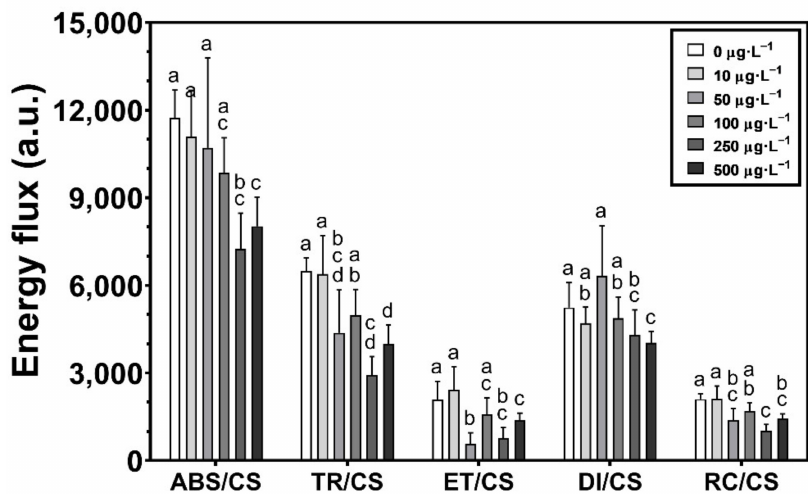
Figure 2. The energy fluxes (absorbed (ABS/CS, trapped (TR/CS), transported (ET/CS) and dissi- pated (DI/CS)) and the number of available reaction centers per cross-section (RC/CS), in Ulva lactuca following a 48-h exposure to a glyphosate-based herbicide formulation in different concentrations (mean ± s.d., n = 18, different letters indicate significant differences between treatments at p < 0.05). Through a deeper analysis, the different components of the photosystems and the elec- tron transport chain (ETC) in response to GBH concentration were determined (Figure